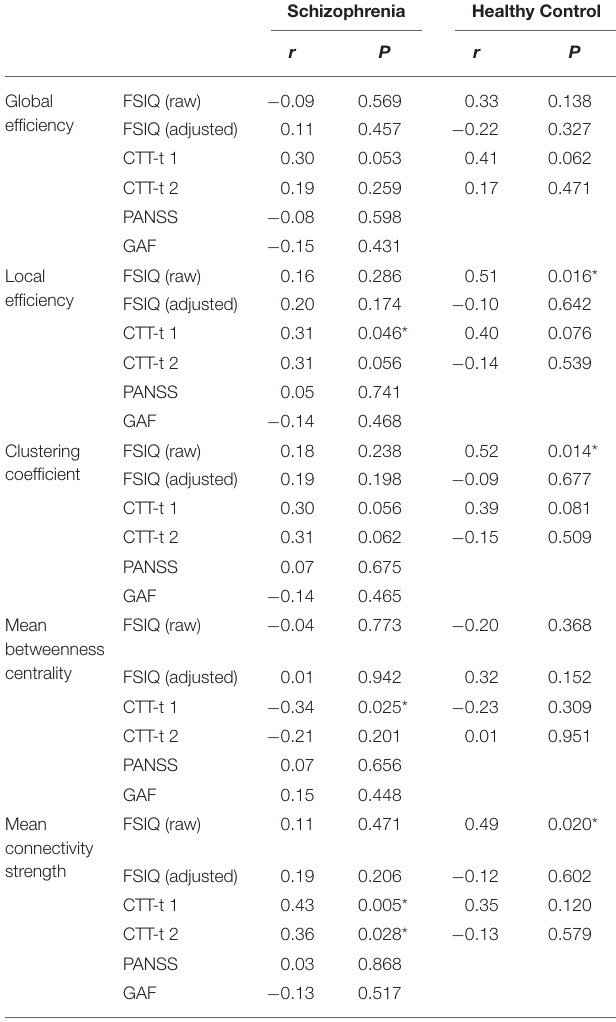
TABLE 4 | Relationship between network characteristics and clinical